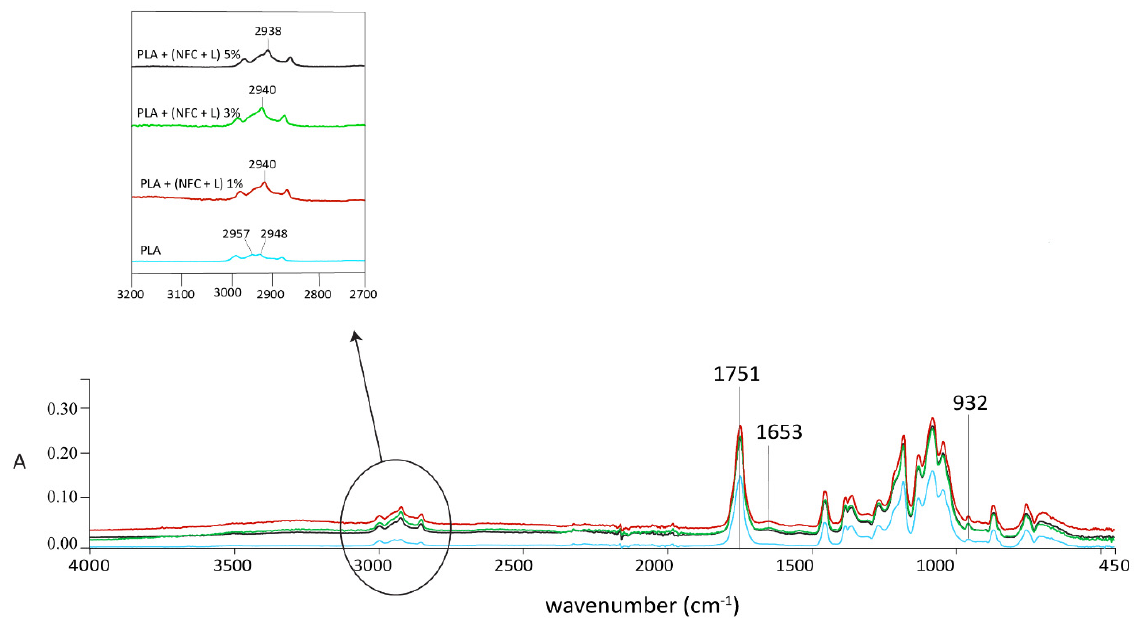
Figure 6. FTIR spectra of GR2 samples at wavenumbers of 4000–450 cm − 1 . The addition of NFC + PL into the PLA matrix of the filament increased the intensity of peaks, as shown in Figure 7. The lowest intensity was found in the sample with 100% PLA. After the surface polymerisation of lignin, the peaks at 1509/1506 and 1661 cm − 1 , which belonged to the valence vibration of the aromatic ring, were more pronounced. How- ever, the peak at 932 cm − 1 , which belonged to the C − OH oscillation, slightly decreased, indicating a possible connection of lignin via the ether bond. In all the analysed samples, both the intensity and appearance of peaks typical of NFC, L, or PL were more pronounced if the amounts of NFC, NFC + L, and NFC + PL were greater